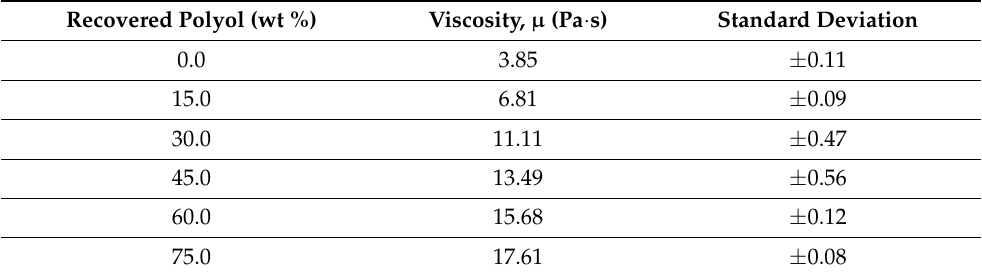
Table 6. Viscosity of the pure polyol and of the mixtures of pure and recovered polyol employed for the synthesis of the foams.